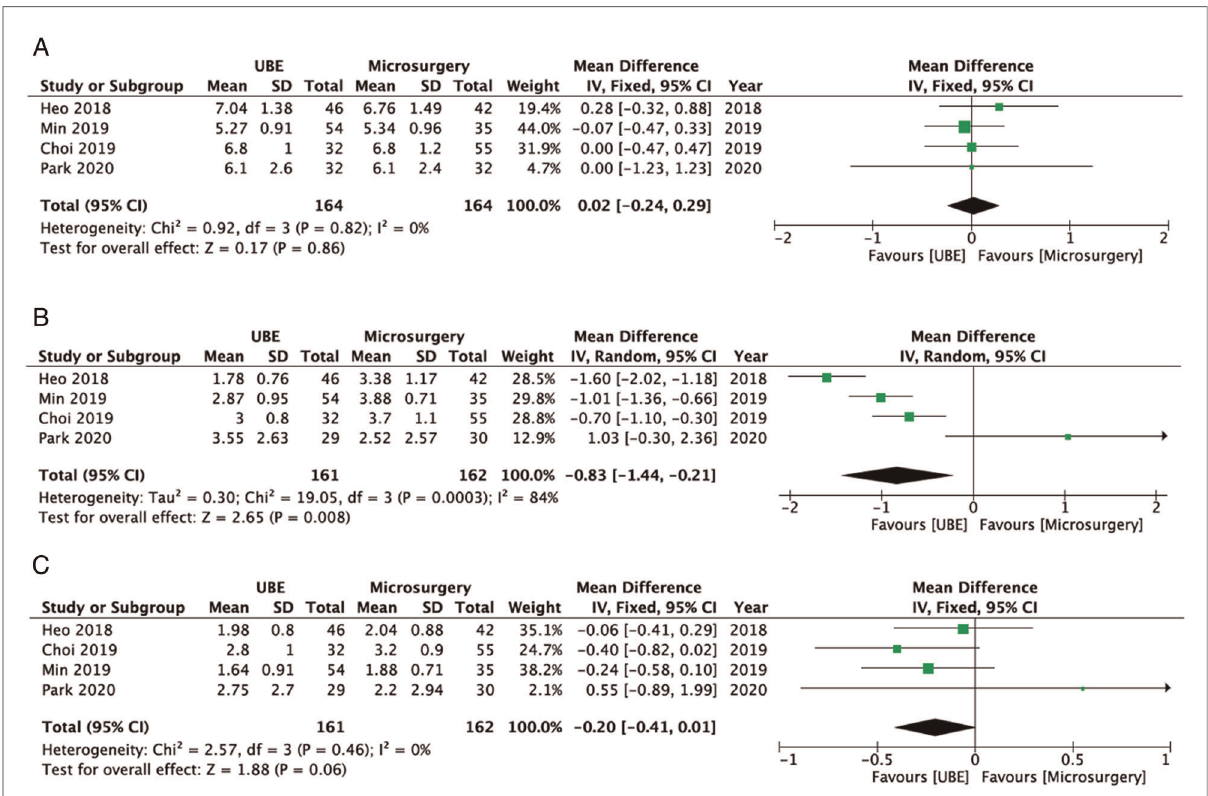
FIGURE 5 Forest plots for comparison of VAS for back at preoperative ( A ), early (<3 months) postoperative ( B ), and fi nal follow-up ( C ) between UBE ULBD and microscopic ULBD. VAS, visual analog scale; UBE, unilateral biportal endoscopic; ULBD, unilateral laminectomy with bilateral